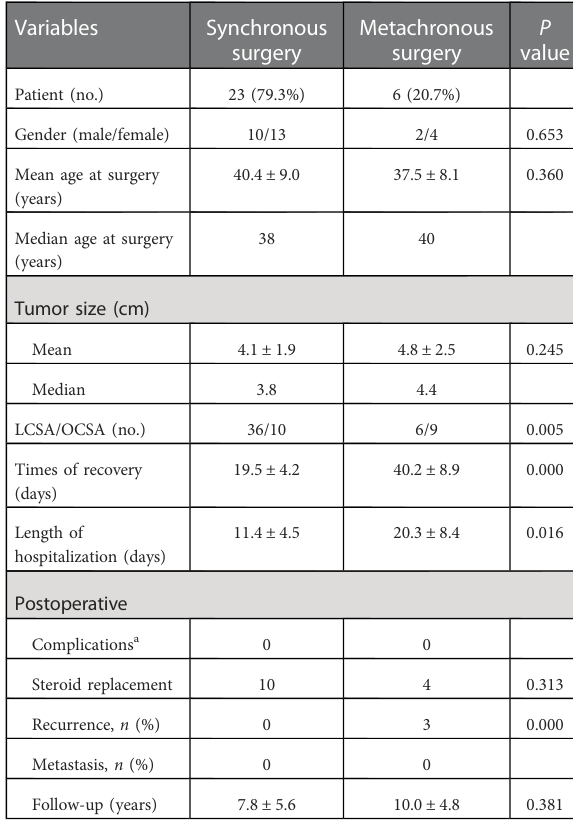
5 patients in the transperitoneal supine position and 2 patients